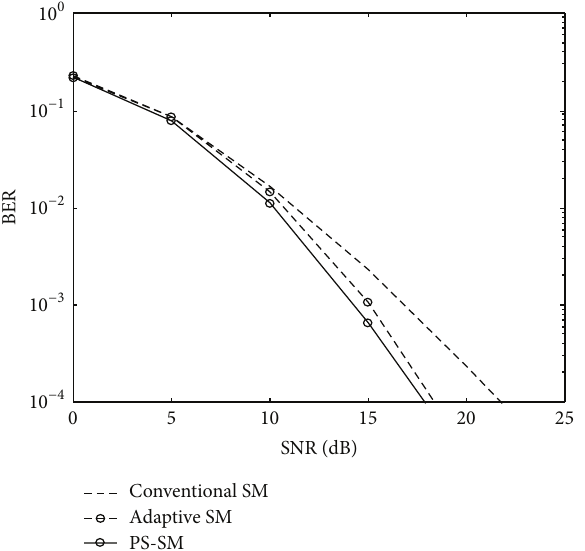
Figure 3: Performance comparisonof SM, ASM, and PS-SM on 2×2 MIMO channels.